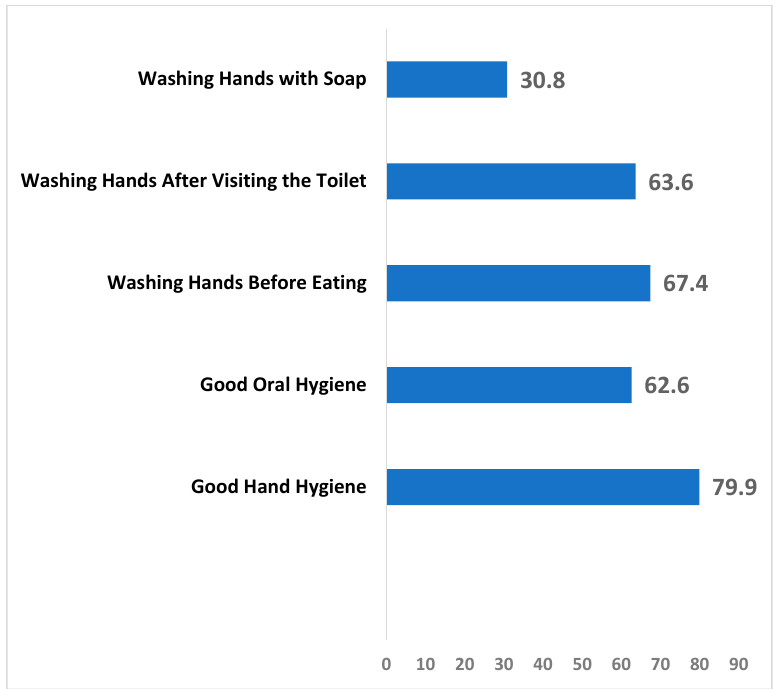
Figure 1. Prevalence of good oral and hand hygiene. Source: GSHS 2012. Good hand hygiene: proportion of those who indicated always to all three questions on hand washing. Good oral hygiene: brushing at least twice daily.